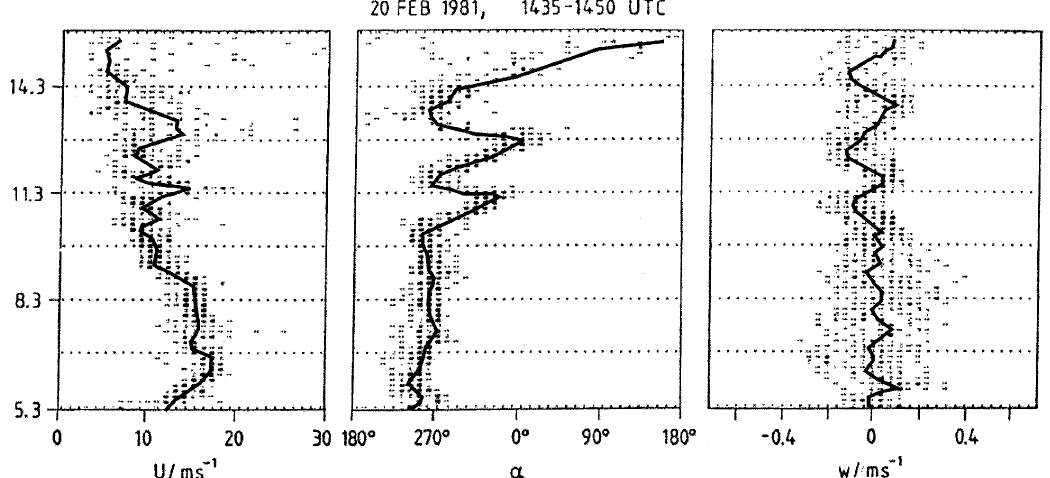
Fig. 12. Wind speed U , direction a and radial velocity w in vertical beam showing wave oscillations in the lower stratosphere (after Ro¨ ttger, 1984)